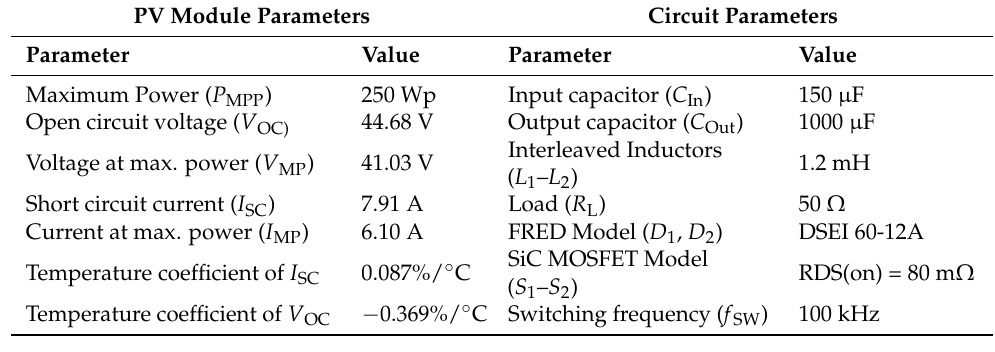
Table 1. PV Module and Circuit Parameters.